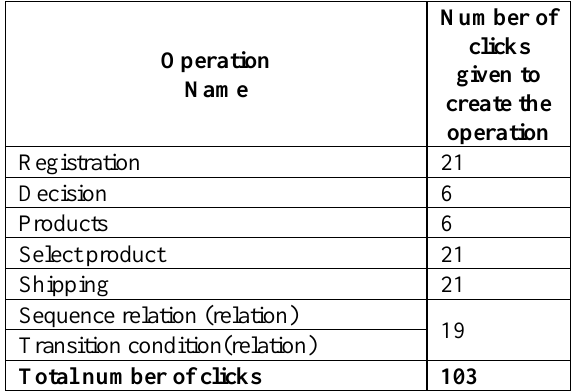
Table 2. Number of clicks given for each operation and relation